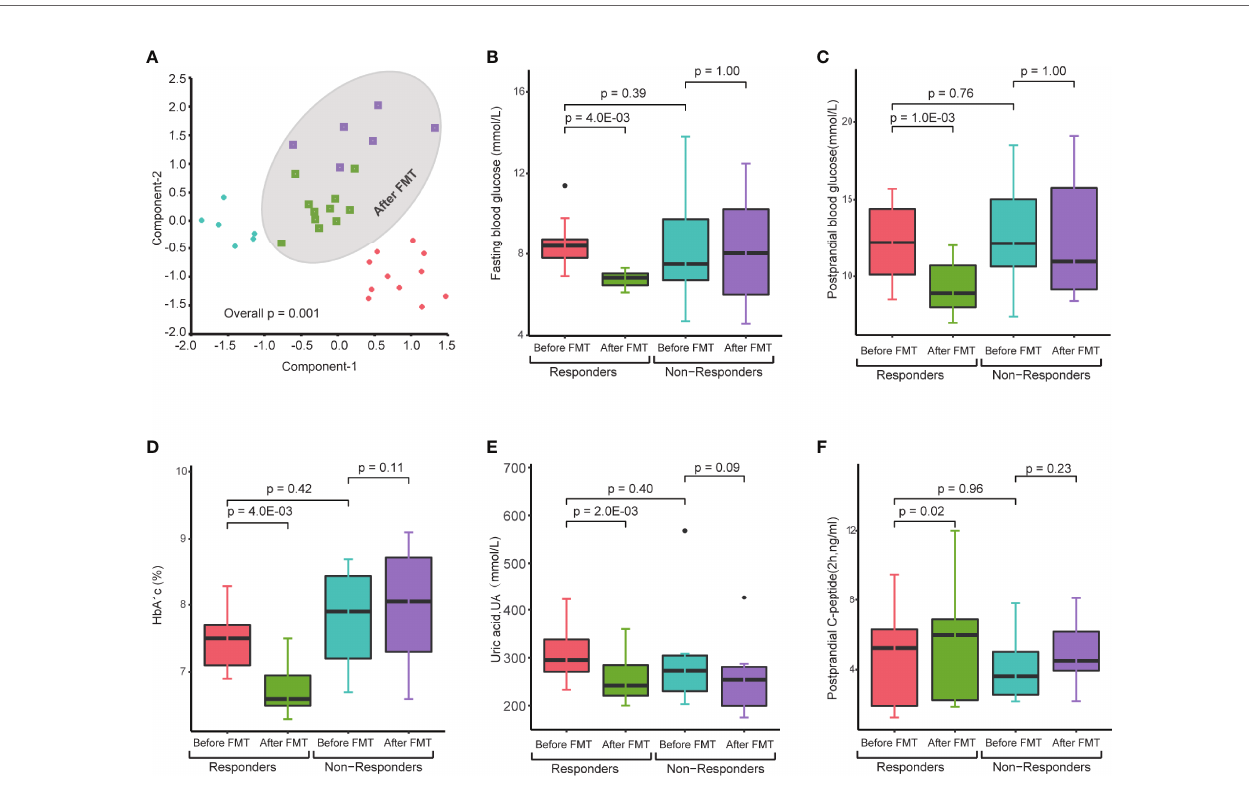
FIGURE 3 | Changes in gut microbiota and clinical factors after FMT treatment. (A) PCA of gut microbiomes of T2DM patients before and after FMT treatment. The microbiome samples after FMT (inside green circle) are separated from pretreated microbiome samples (outside green circle). Clear separation of pretreated microbiome samples between responders (red diamonds) and nonresponders (blue diamonds). (B – F) These boxplots show changes in clinical factors before and after FMT treatment in responders and nonresponders. The p-values within the responder and nonresponder groups were obtained by Mann – Whitney paired test, and p-values across groups were obtained by Mann – Whitney rank-sum